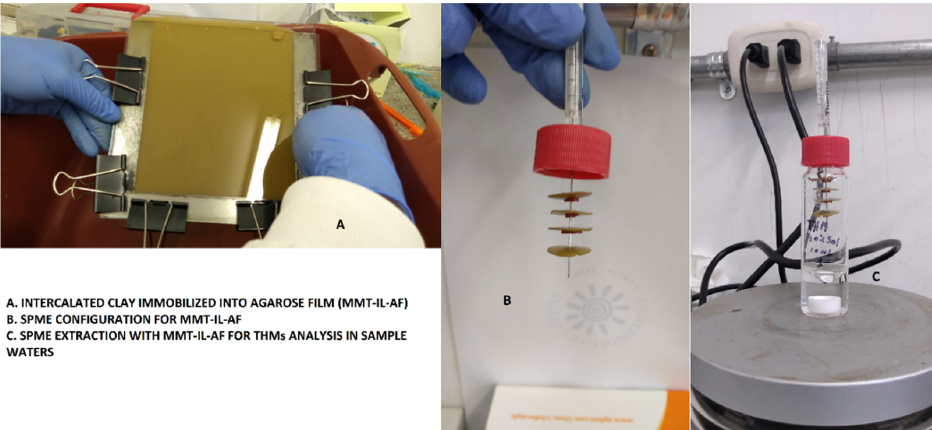
Figure 1. Assembly of montmorillonite intercalated with ionic liquids on an agarose film for THM extraction from water samples as HS-SPME configuration [18].